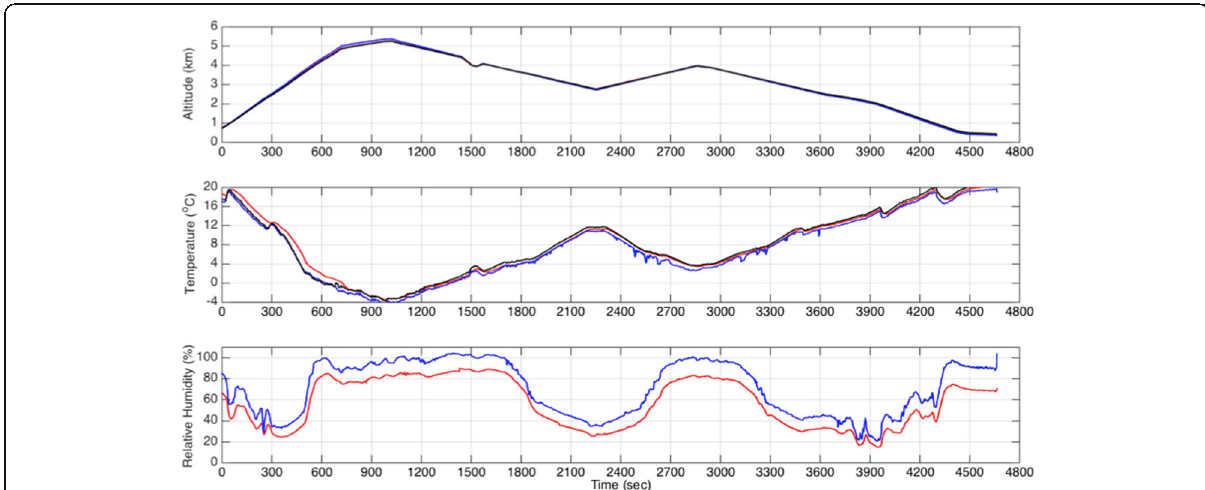
Fig. 6 The altitude ( top panel ), temperature ( middle panel ), and relative humidity ( bottom panel ) as a function of time for UAV 17. In the temperature and humidity plots, the blue curve corresponds to the sensors on iMET, the red curve to the DH sensors, and the black curve to the cold wire (CW) sensor. There is general agreement between the various sensors, except for the fact that an offset of − 0.8 °C had to be applied to the DH and CW temperature data and +15% to the DH humidity data. The altitude plot shows altitude derived from the DH ( black ) and iMET ( blue ) pressure